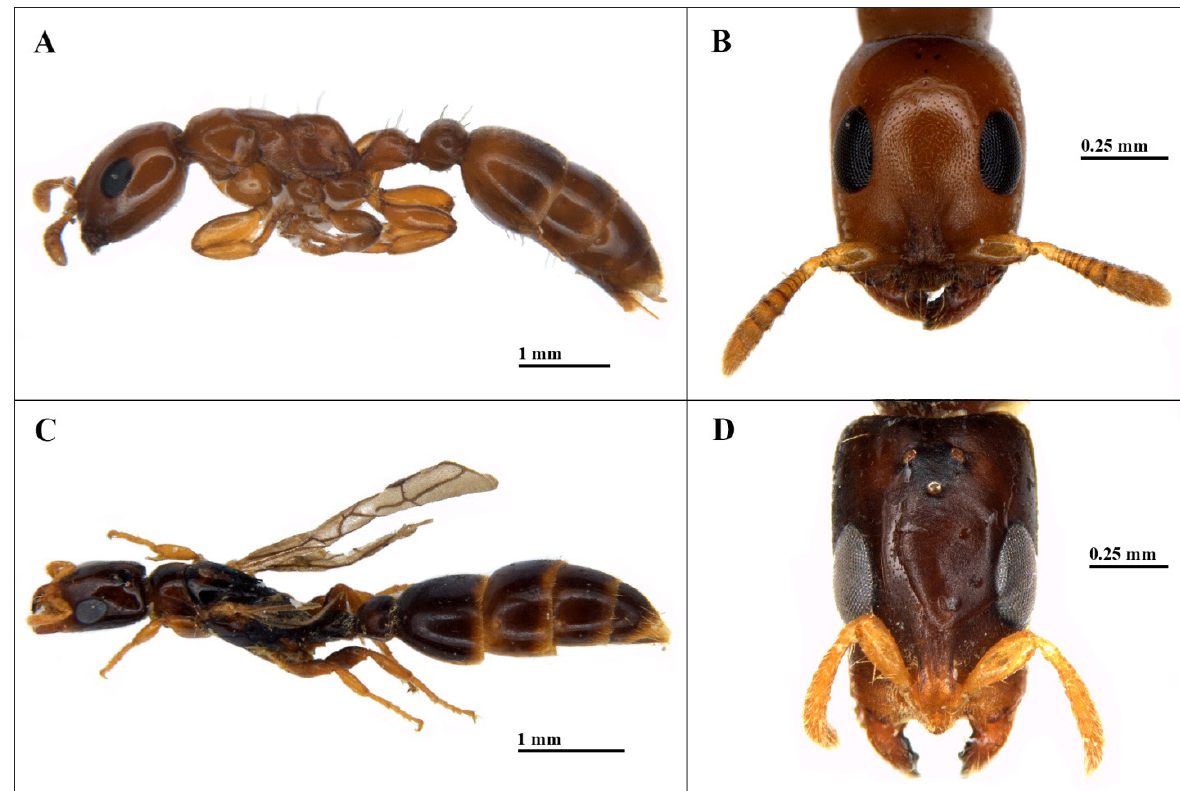
Fig 3. Myrcidris epicharis ( F. Santana , CZPB). A worker in lateral view (A) and full-face view (B). Queen in lateral view (C) and full-face view